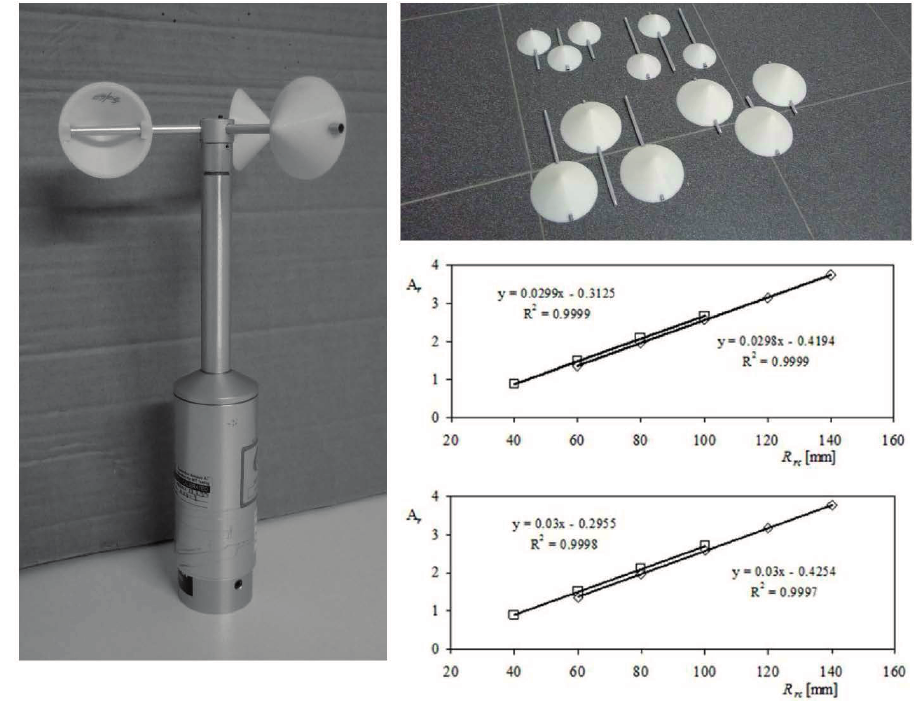
Figure 9. Climatronics 100075 anemometer equipped with conical cups rotor with dimensions: R c = 25 mm, and R rc = 60 mm (right). Some of the cups made of ABS plastic in a 3D printer ( top-right ); Calibration coefficients, A r , as a function of the cups’ center rotation radius, R rc ( bottom-right ); Results from Climatronics 100075 ( top graph ); and Ornytion 107A ( bottom graph ) anemometers: squares stand for R c = 25 mm cups rotors, rhombi stand for R c = 40 mm cups